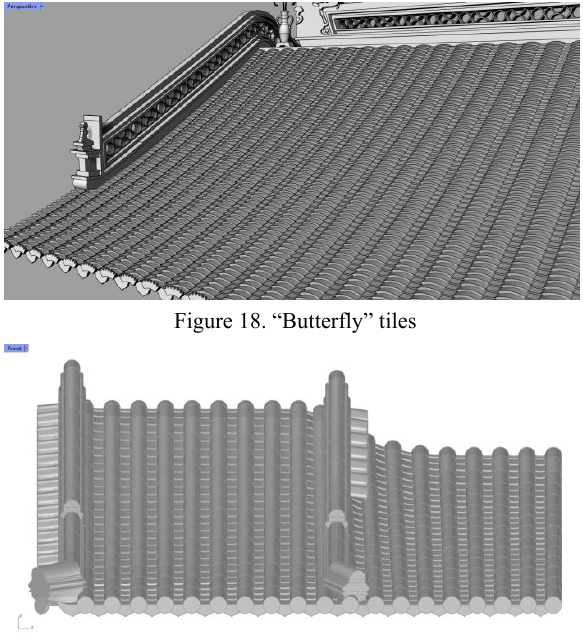
Figure 15. Comparison of different levels of geometry details